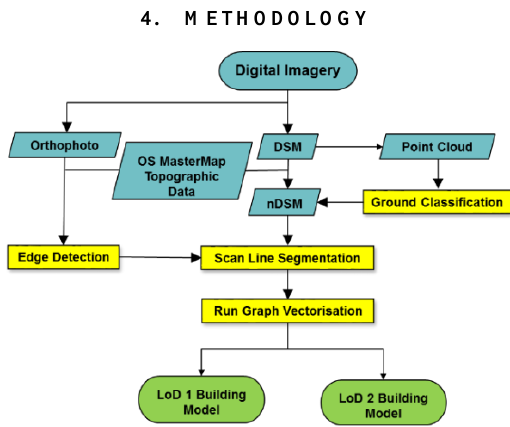
Figure 2. Developed workflow for automatic 3D building